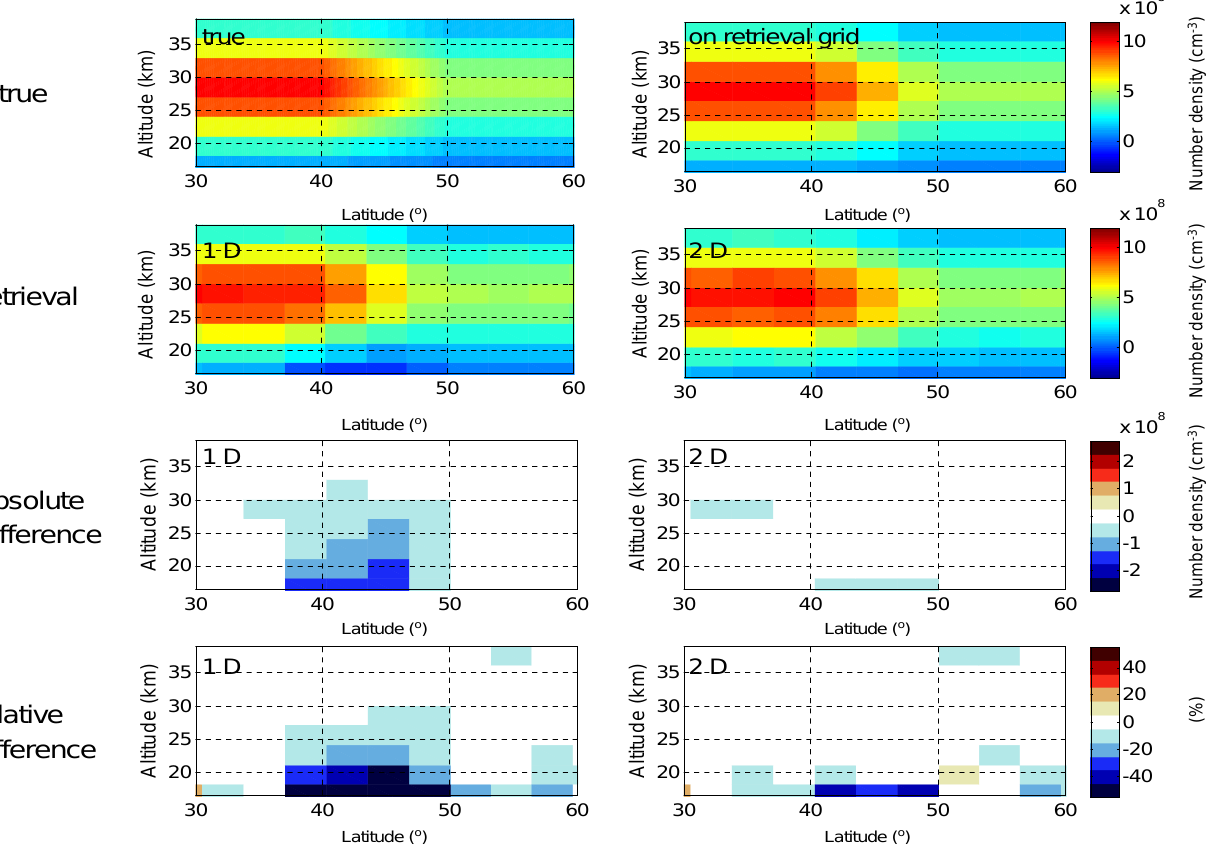
Fig. 11. Upper row left: assumed NO 2 distribution with a negative gradient towards the instrument. Upper row right: the same profiles but gridded on the SCIAMACHY retrieval grid. Second row: NO 2 profiles obtained by the 1-D retrieval (left) and 2-D retrieval (right). The absolute and relative differences between the original (true) profile averaged on the SCIAMACHY retrieval grid and the retrievals for the simulations are shown in the third and bottom row, respectively.